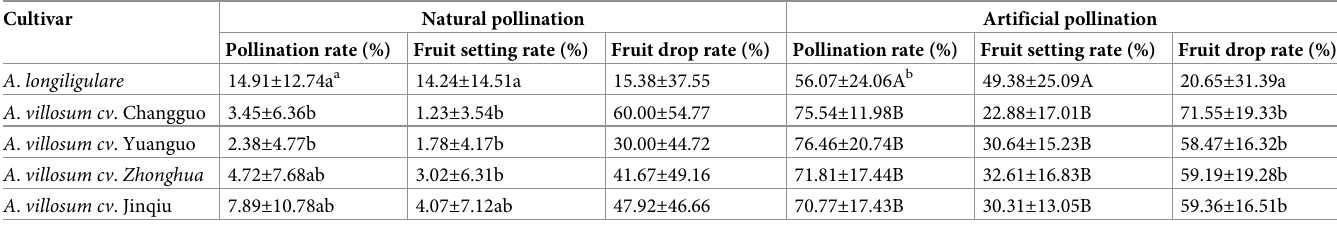
Table 2. Effects of different pollination methods on fruit setting rate and fruit dropping rate of 5 amomum germplasms in response to pollination. Cultivar Natural pollination Artificial pollination